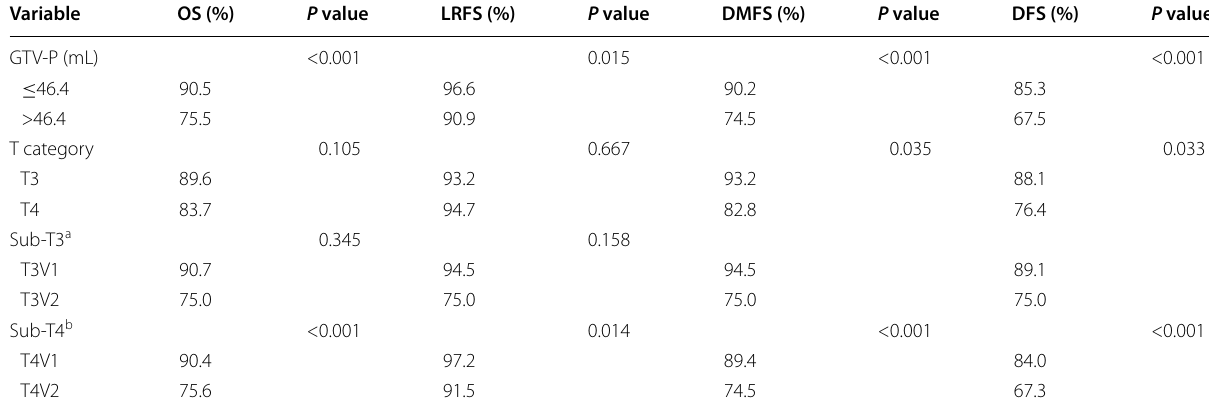
OS overall survival, LRFS local relapse-free survival, DMFS distant metastasis-free survival, DFS disease-free survival a T3 tumors were subclassified as T3V1 (T3 tumors with GTV-P b T4 tumors were subclassified as T4V1 (T4 tumors with GTV-P